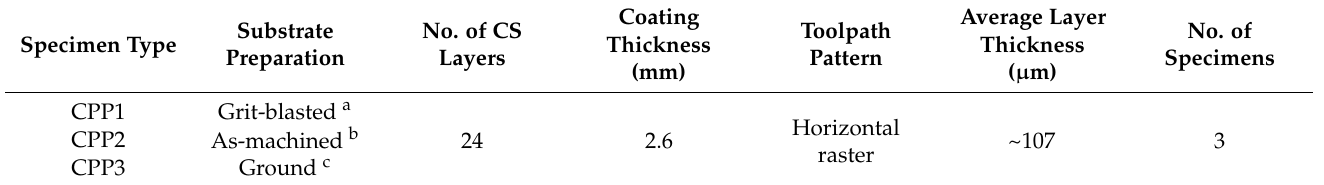
Table 3. Specimen details used for evaluating interfacial adhesion strength.